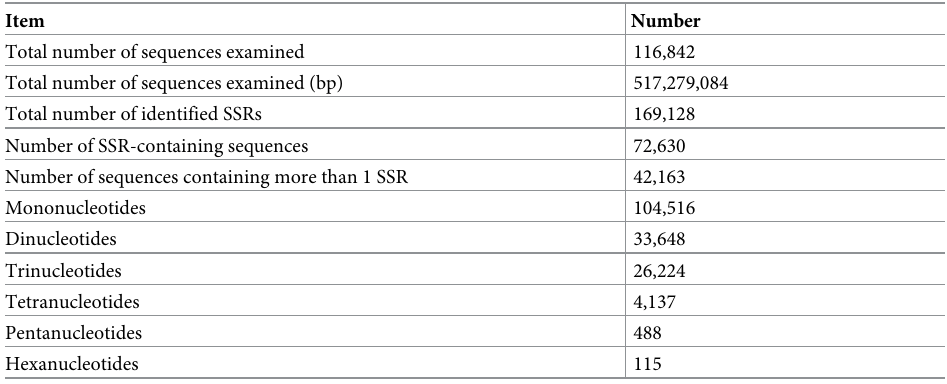
Table 5. Statistical analysis of